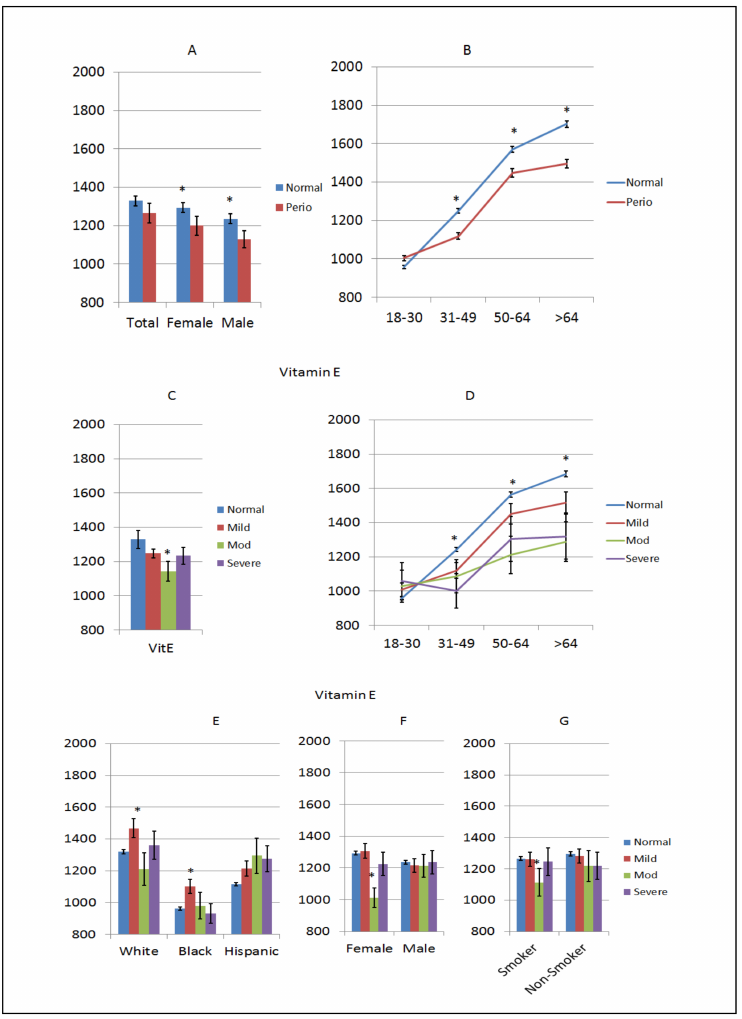
Figure 5. Levels of vitamin E ( µ g/dL) in subjects with or without periodontitis stratified upon sex ( A ), age ( B ), disease severity ( C ), disease severity and age ( D ), race/ethnicity ( E ), disease severity and sex ( F ), and disease severity in smokers ( G ). The bars denote group means and the vertical brackets enclose 1 SEM. The asterisk (*) denotes significantly different than the normal group at p <